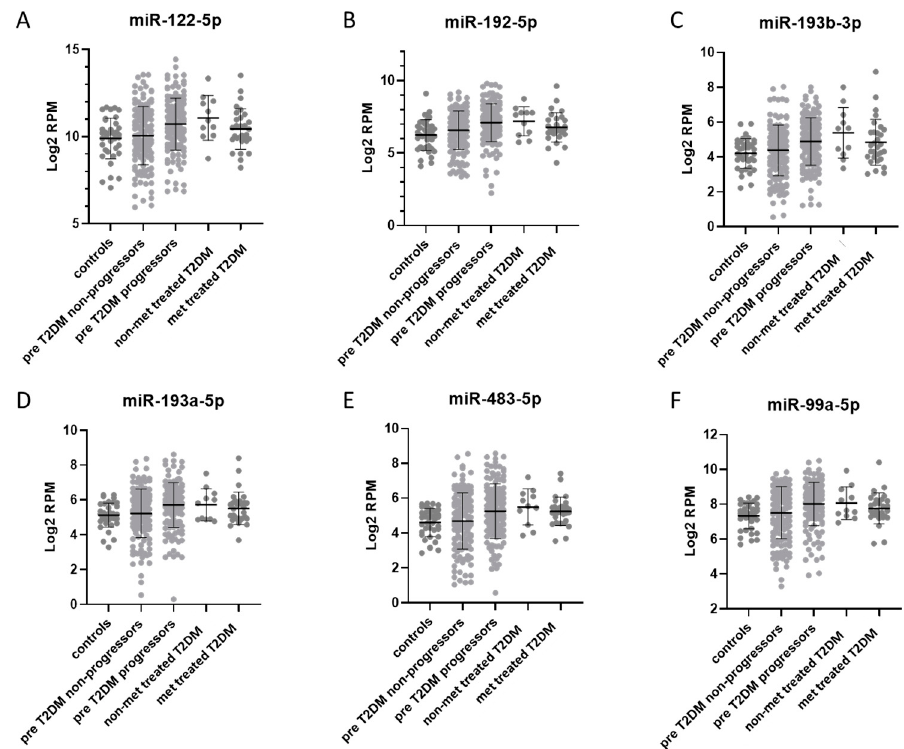
Figure 7. Comparison of plasma miRNAs between METSIM (prediabetic T2DM) and MetaHIT (T2DM treated with metformin). ( A ) miR-122-5p, ( B ) miR-192-5p, ( C ) miR-193b-3p, ( D ) miR-193a-5p, ( E ) miR-483-5p, ( F ) miR-99a-5p. Plots of selected plasma miRNAs that overlap between METSIM and MetaHIT datasets. The levels of miRNAs from MetaHIT data are shown as dark grey dots, while the miRNA levels from the METSIM data (Ghai et al. 2019a) are shown as light grey dots. The values are in log2 RPM (log2 transformed reads per million), with each dot representing a patient sample.